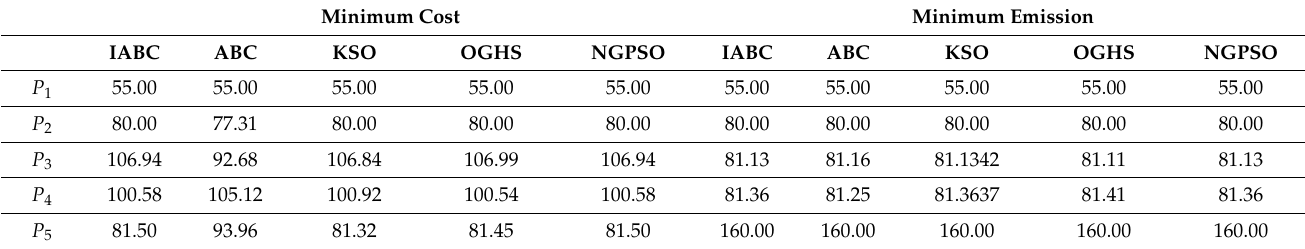
Table A3. Minimum cost and minimum emission (Case